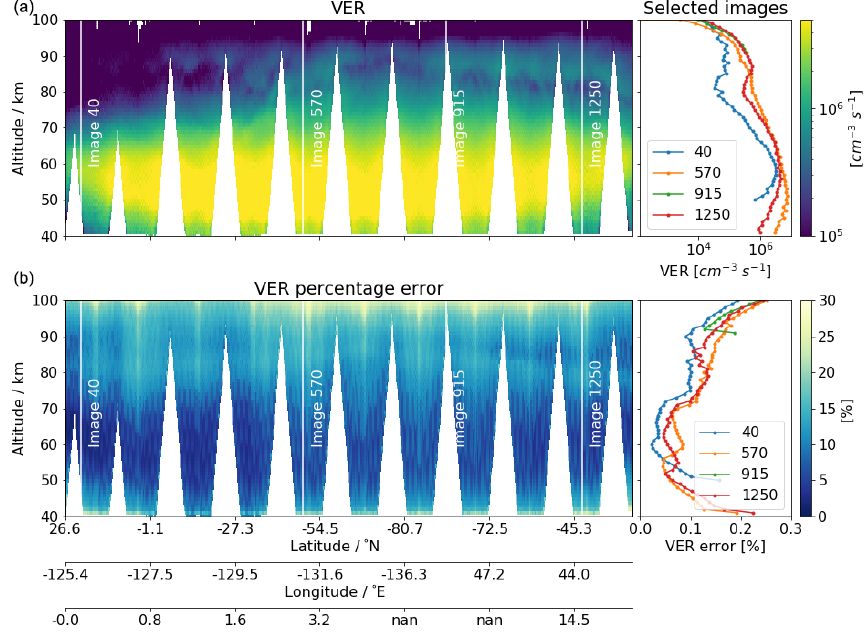
Figure 4. An example of the retrieved volume emission rate of O 2 (a 1 (cid:49) g ) from IRI during daytime for one orbit collected on 2 January 2008, from 15:14:24 to 16:2:31 (orbit number 37400), and its random error relative to the individual a priori profile ( a and b , respectively). The panels on the left are 2D-colour plots, as a function of geographical location and altitude. Time after local sunrise is also shown in the horizontal axis, where “nan” indicates a location near the summer pole where the sunrise is absent. The panels on the right are the vertical profiles of the four selected images (along the four white lines in the left panels). All results shown here have a measurement response greater than